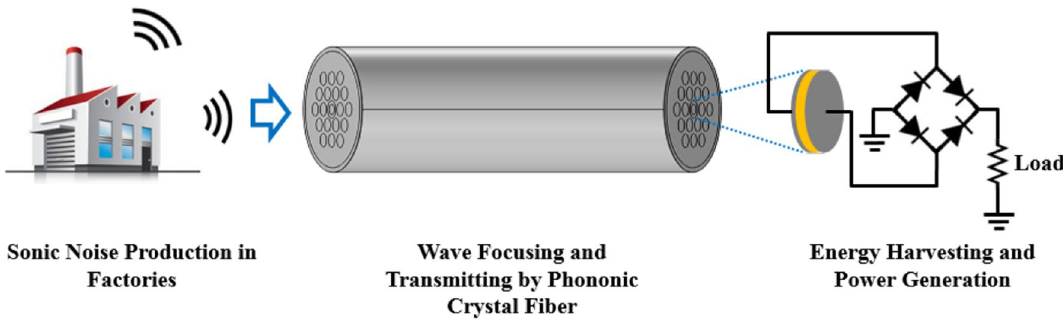
Figure 1. Power generation process by phononic crystal